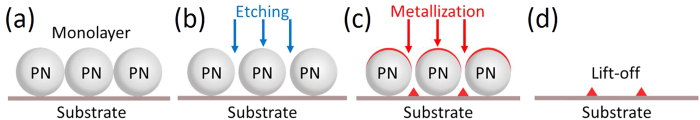
Steps of nanosphere lithography (a) monolayer formation (b) diameter reduction (c) metal deposition (d) lift-off.